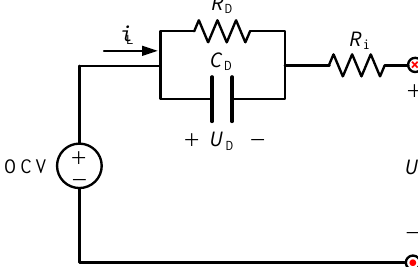
Figure 1. Schematic diagram of lumped parameter battery mode. OCV: open circuit voltage.